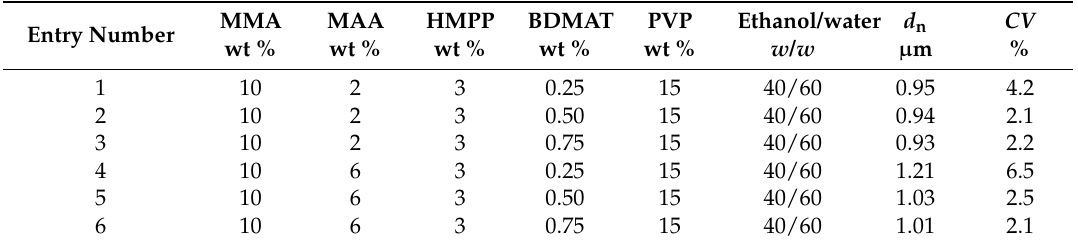
Table 2. Synthesis and characterization data for polymeric microspheres prepared by photoinitiated RAFT dispersion polymerization of MMA at different BDMAT concentrations with either 2 or 6 wt % MAA *.